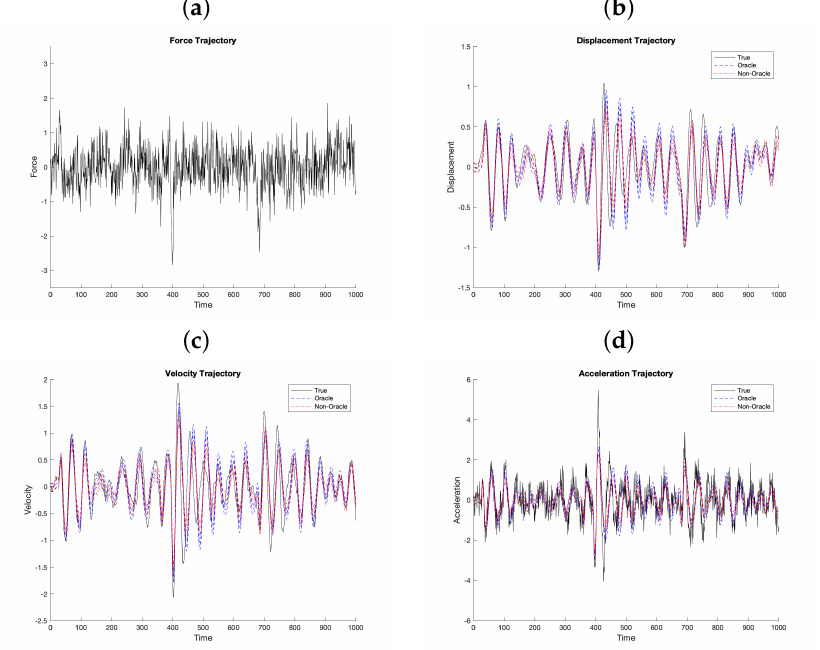
Figure 5. Validation Force ( a ) Displacement ( b ), Velocity ( c ), and Acceleration ( d ) trajectories. The Dis- placement, Velocity, and Accelerations have 95% posterior predictive intervals as